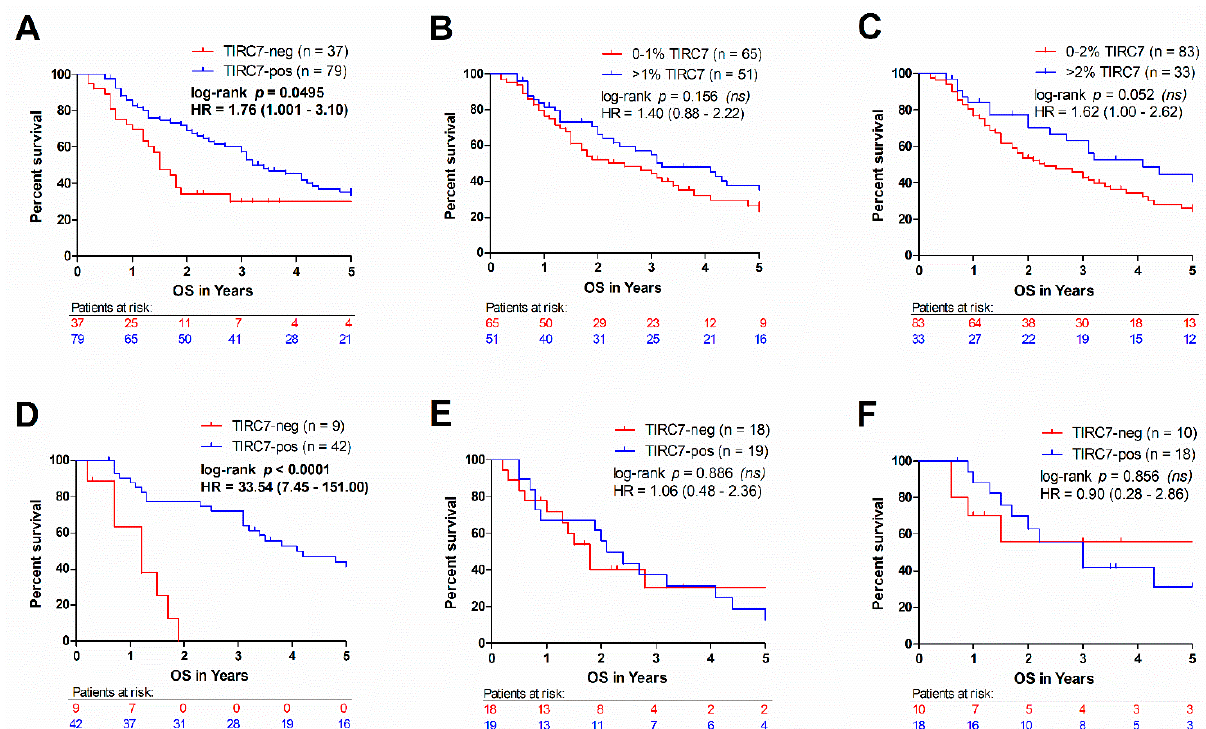
Figure 4. Survival analysis in relation to TIRC7 quantity. Cases with absent TIRC7 + intraepithelial cells showed a remarkably shortened survival as compared to TIRC7-positive cases across all CCA types ( A ). An analogous trend was also seen when using the median ( B ) and the mean ( C ) value of intraepithelial TIRC7 + immune cell density as stratification cut-offs. Subgroup analysis revealed a strong survival benefit of TIRC7-positive cases in iCCA ( D ), while no differences were found with respect to pCCA ( E ) and dCCA ( F ). p -values were computed using log-rank testing. Hazard ratios (HR) and its 95% confidence intervals were calculated using the Mantel Haenszel approach.